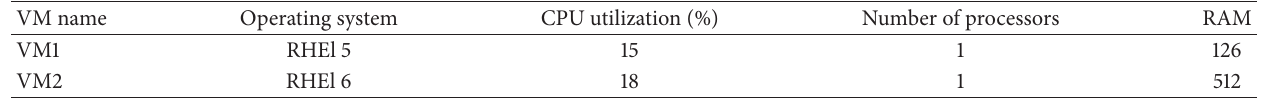
Table 17: Local list of node 3 (S2).